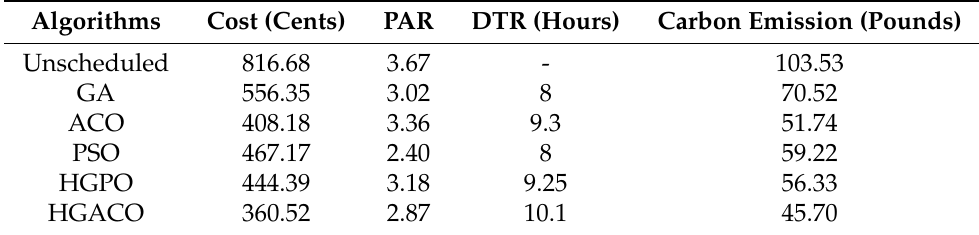
Table 16. Scenario II: performance tradeoff analysis of the proposed and existing algorithms with